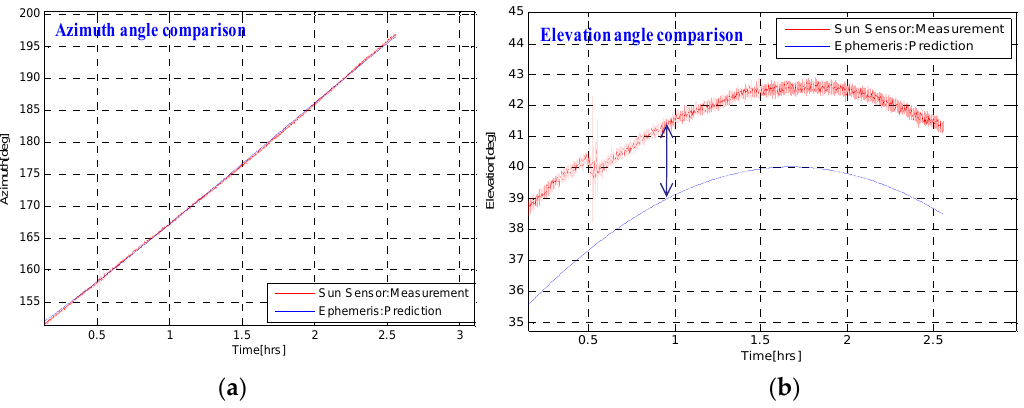
Figure 9. Azimuth angle ( a ) and Elevation angle ( b ) comparison of the EASI algorithm and Sun Ephemeris data. Sensors 2016 , 16 , 749